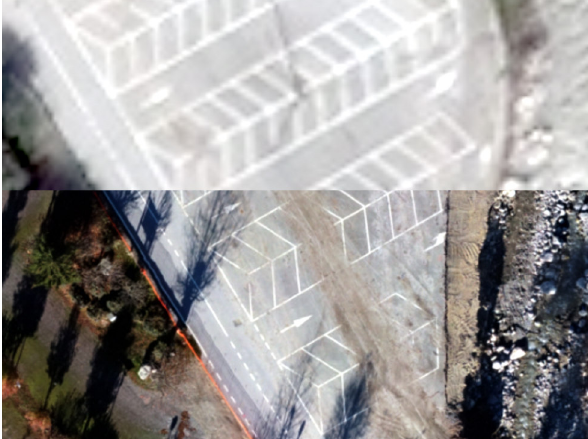
Figure 10 . Qualitative evaluation of satellite orthoimagery (top) level of detail and 2D position accuracy with respect to UAS orthoimagery (bottom).